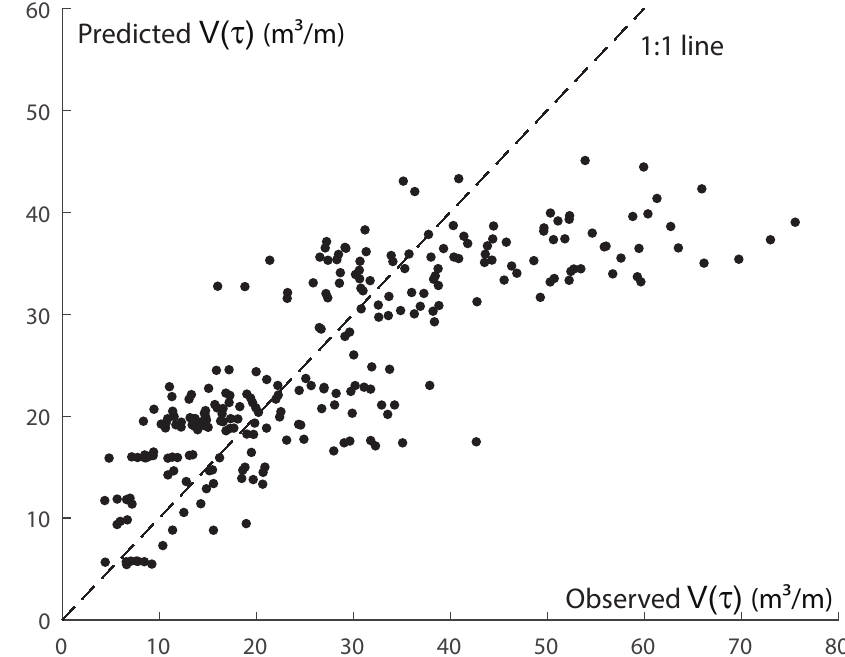
Figure 13. Comparison of predicted volume changes between time instants t and t + τ (i.e., average of the simulated distributions) versus observed volume changes, based on the five Coastal Division profiles at 53 distinct time instants t